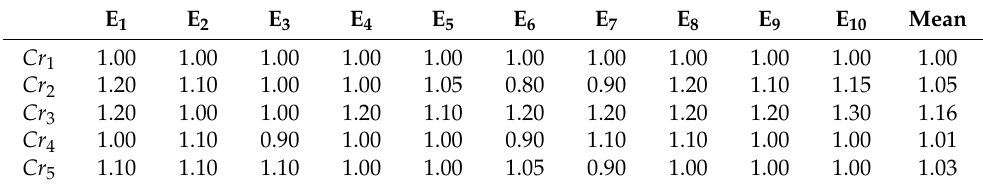
Table 13. Respondents’ attitudes obtained based on the use of the PIPRECIA method.